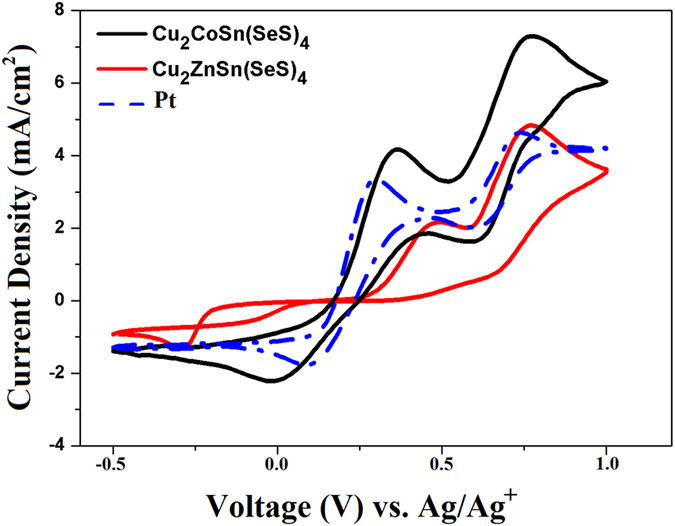
Cylic voltammograms for Cu2CoSn(SeS)4 and Cu2ZnSn(SeS)4 nanocrystals and Pt counter electrodes.